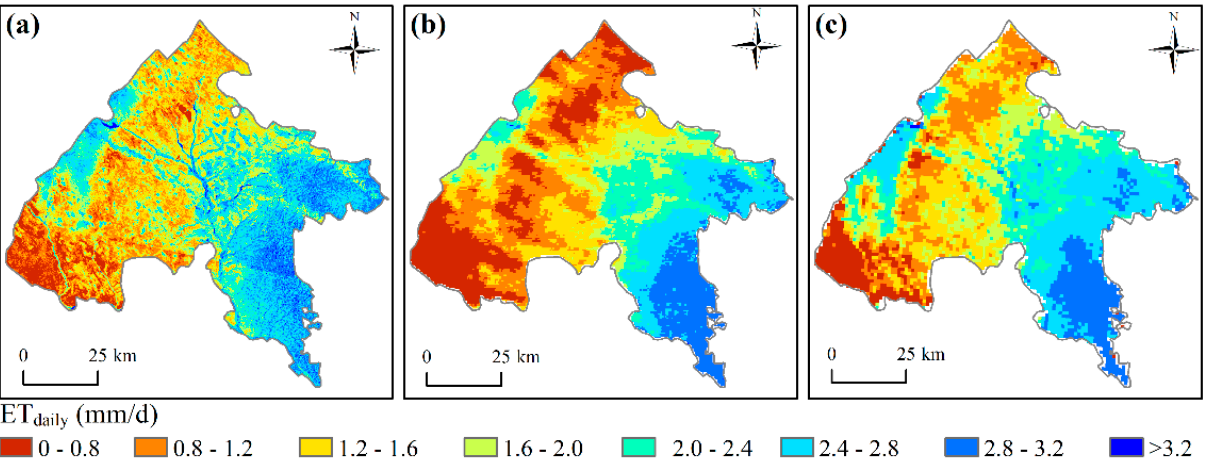
Figure 4. Spatial distribution of ET estimates by ( a ) Landsat TM, ( b ) MODIS, and ( c ) AVHRR over the Yuyang District on 7 August 2011. Transit time for Landsat TM is approximately 11:07 (local time: GMT + 8), for MODIS is approximately 10:30 (local time), and for AVHRR is approximately 10:02 (local time).